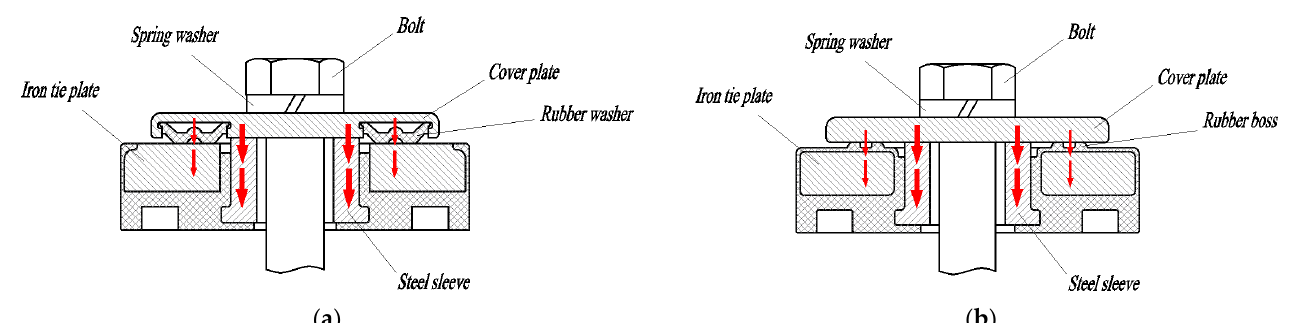
Figure 3. Comparison of the force transmission paths of the two tie-plate structures: structures of the ( a ) original and ( b ) new tie plates.